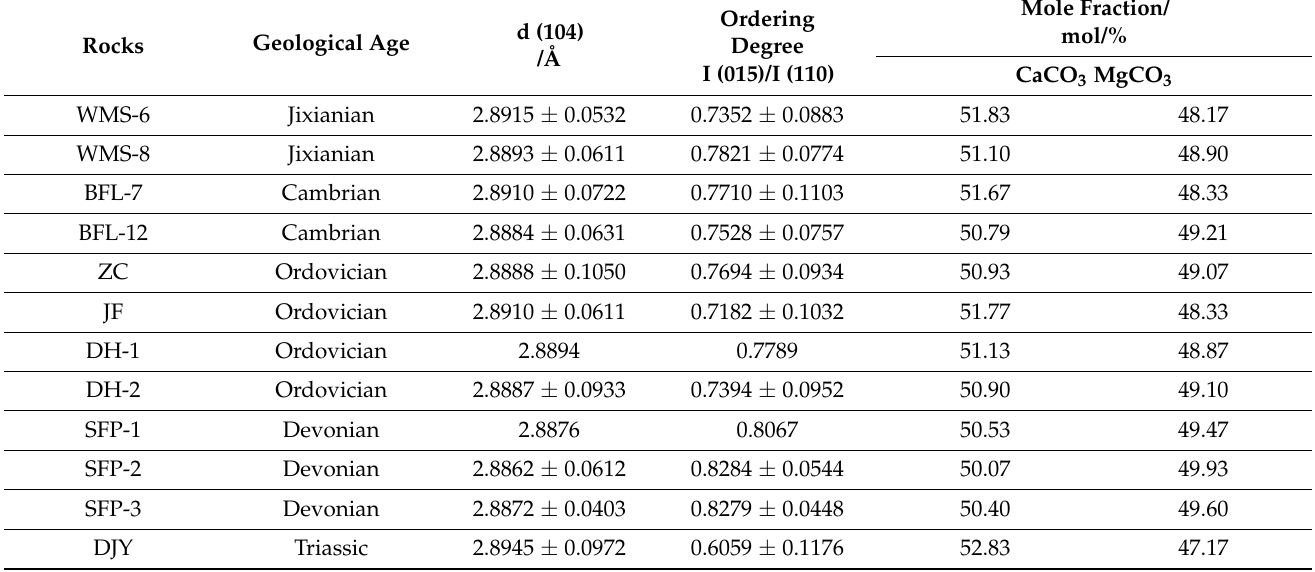
Table 2. The MgCO 3 mole fraction and ordering degree of dolomite crystals in